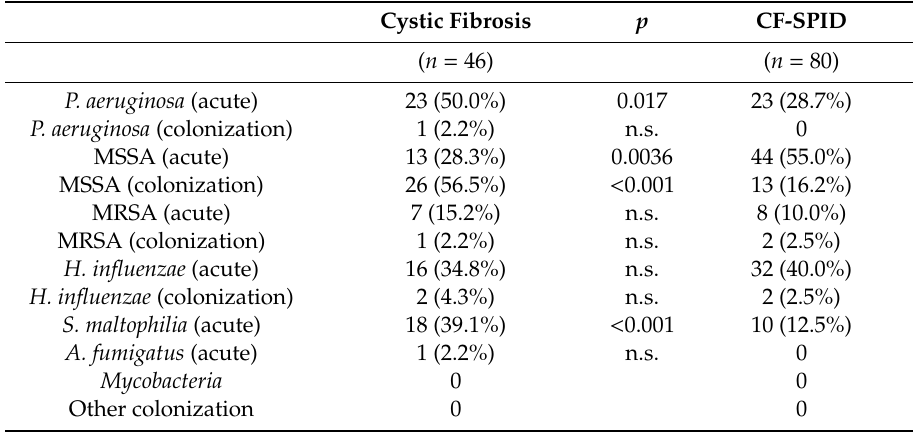
Table 3. Respiratory infections in CF and in CF-SPID